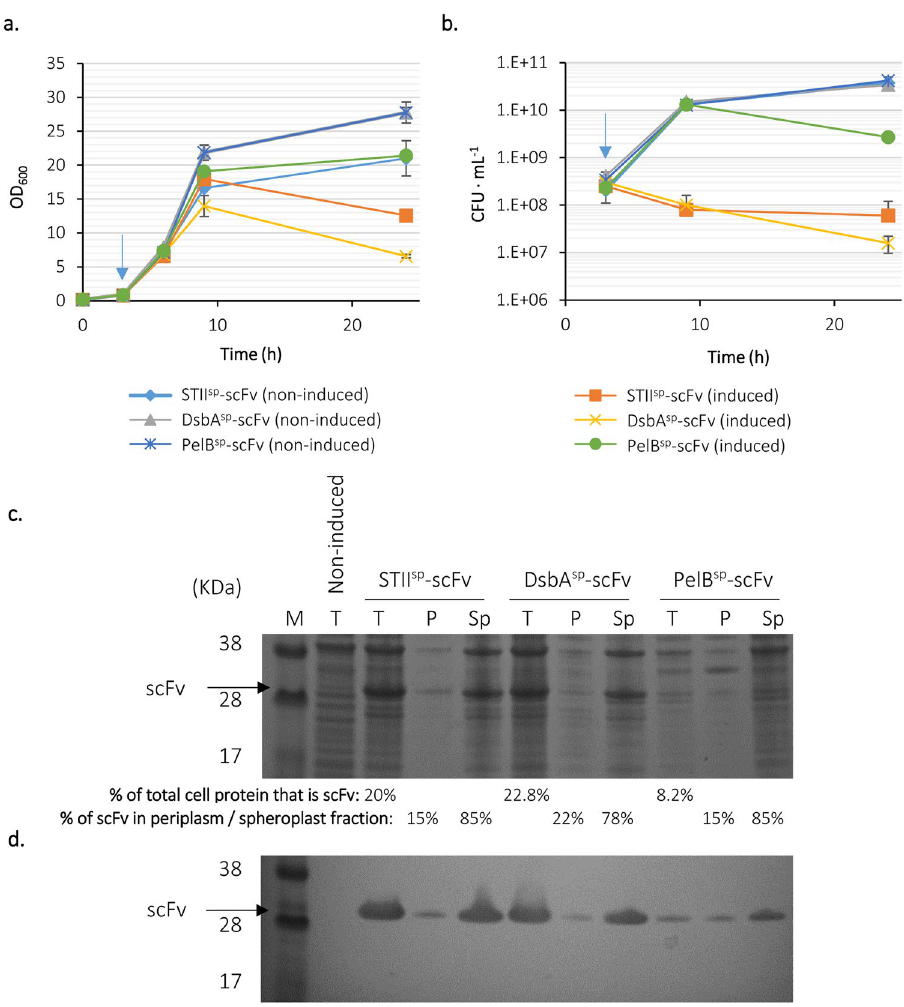
Figure 1. Production of scFv 13R4 in the periplasm using STII, DsbA and PelB signal peptides. E . coli BL21-A carrying the vector encoding scFv 13R4 fused to STII sp , DsbA sp or PelB sp was grown at 25 °C; RPP was induced with 0.02% arabinose at an OD 600 ≈ 0.5 (blue arrow). Upon induction, 0.25% glucose was added to the culture medium. ( a ) The OD 600 and ( b ) CFU of the culture were measured over time. Data are shown as mean values from replica flasks, error bars are ± 1 standard deviation. ( c ) SDS-PAGE and ( d ) Western blot analysis (anti-His) of total (T), periplasm (P) and spheroplast (Sp) fractions after 24 hours growth. A sample of the culture carrying STII sp fused to scFv 13R4 grown under non-induced conditions was used as control. Percentages of total cell protein that was scFv and the distribution of scFv between periplasmic and spheroplast fractions shown below ( c ). Uncropped gel images are available in Supplemental Fig.